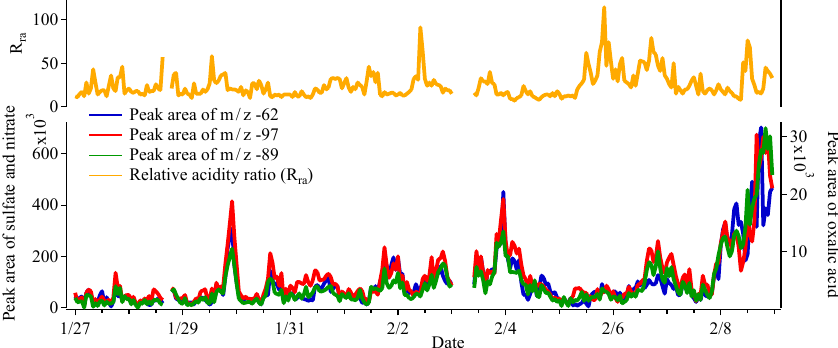
Figure 9. The temporal variations in peak area of nitrate, sulfate, and oxalic acid and the relative acidity ratio ( R ra ) in carbonaceous oxalic acid particles in